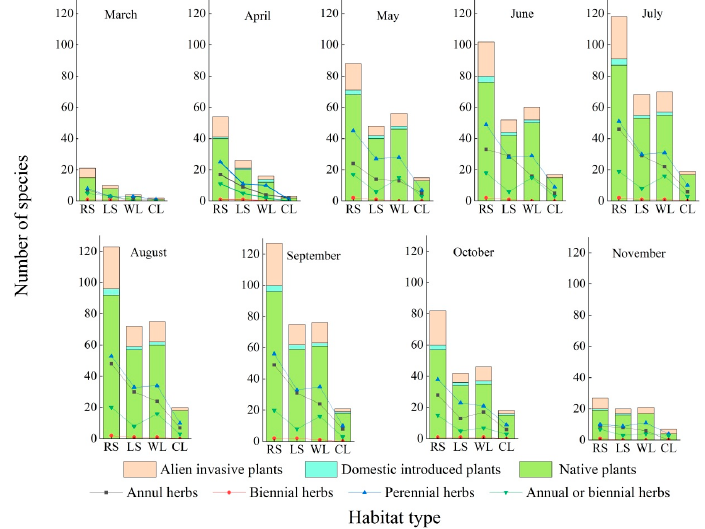
Figure 6. Spatiotemporal variations in species of spontaneous plants from different sources and in different life forms. RS—roadside, LS—lakeside, WL—woodland, CL—coastline. From March to November, the proportion of domestically introduced and alien in- vasive plant species to the total species of spontaneous plants in the four habitats varied between 10.53% and 33.33%. The average proportion of domestically introduced and al- ien invasive plant species to the total species of spontaneous plants in the four habitats was the highest (27.17%) in April, and the proportion was the highest in the coastline habitat, followed by those of the roadside and woodland habitats, and along the coast- line. From May to September, the proportion of domestically introduced and alien inva- sive plant species to all the species of spontaneous plants in the roadside habitat was the highest, followed by those of the woodland and lakeside habitats, and was the lowest in the coastline habitat. The proportion was the highest in the roadside habitat, followed by those of woodland and lakeside habitats, and was the lowest in the coastline habitat during October. The proportion was the highest in the roadside habitat, followed by the coastline and woodland habitats, and was the lowest in the lakeside habitat in Novem- ber (Figure 7).